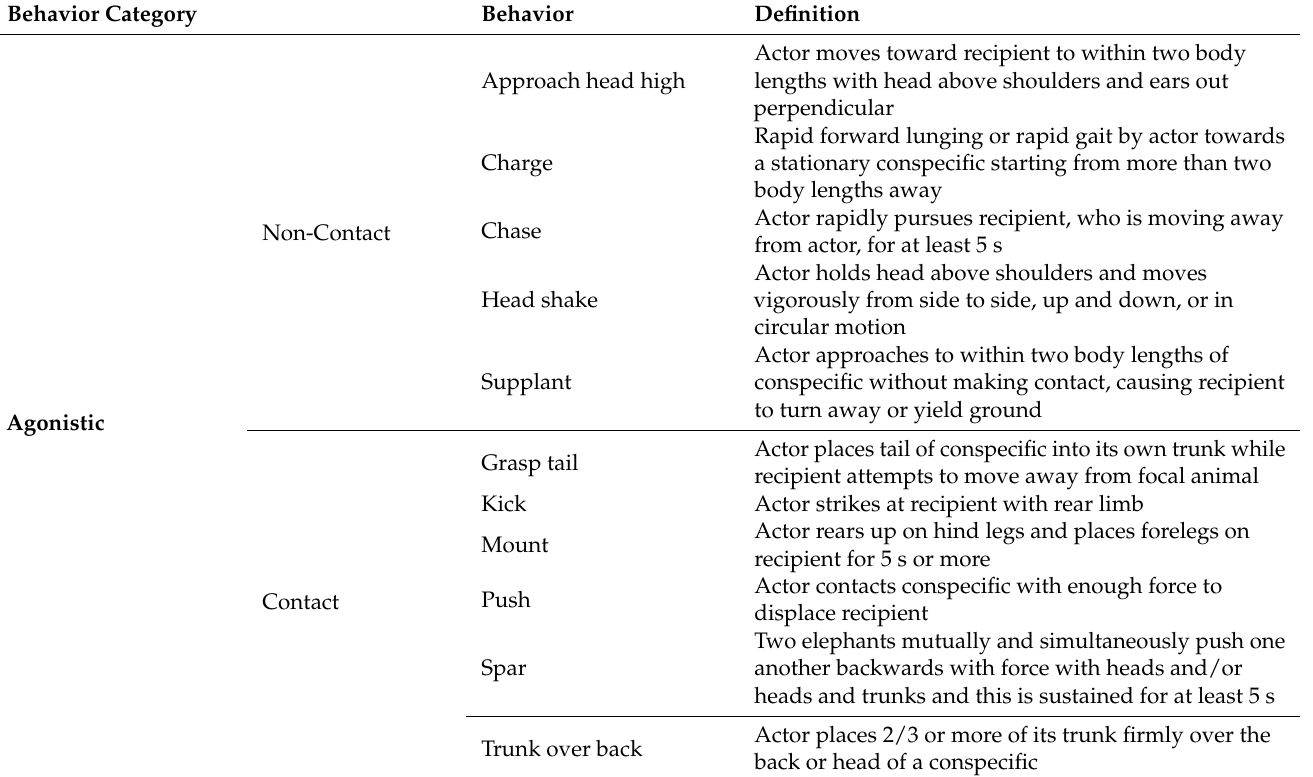
Table 1. Ethogram of Behaviors for a Bachelor Group of Five Bull Asian Elephants at Denver Zoo [35,36]. Reprinted by permission of the publisher (Taylor & Francis Ltd., http://www.tandfonline. com accessed on 28 January